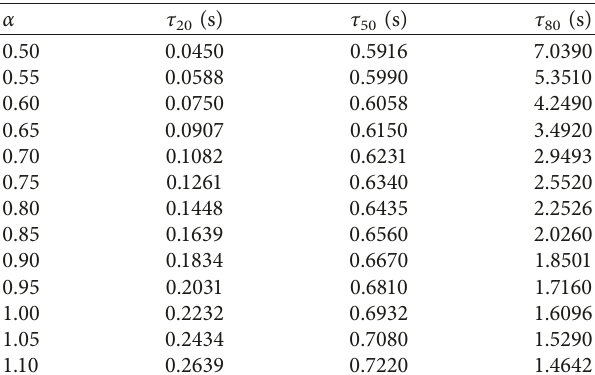
Table 4: Numeric values of normalized times τ different values of α .